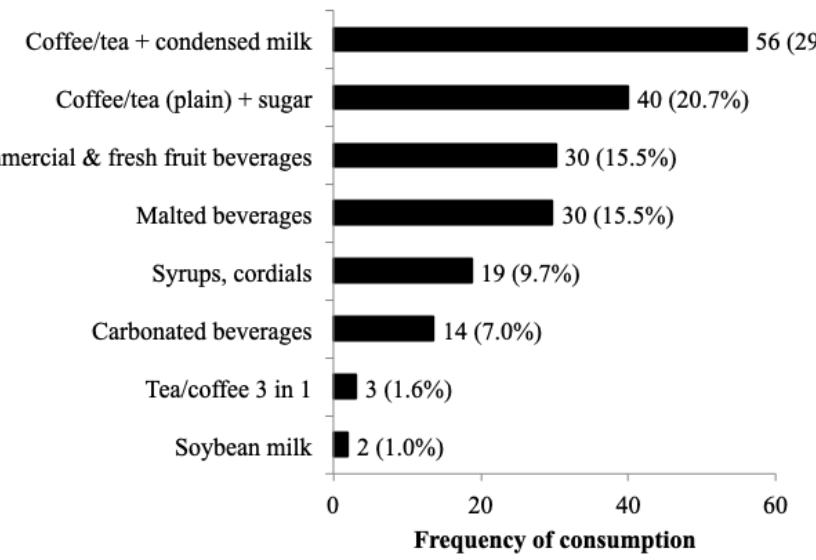
Figure 3. Percent distribution of sugar sweetened beverage choices for SSB T3 subjects ( n = 193). Footnote: data provided as n (%).